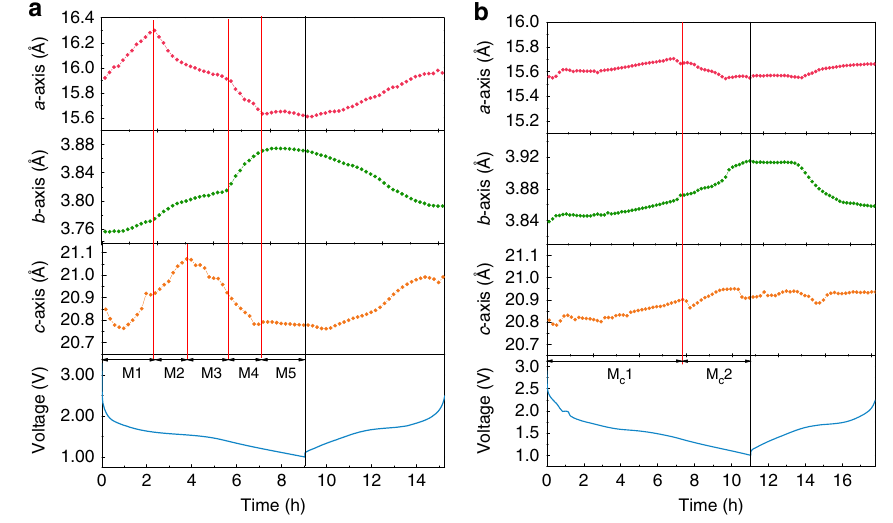
Fig. 7 The voltage pro fi le and the lattice parameter evolution process. a pure TNO. b TNO − x @C 3